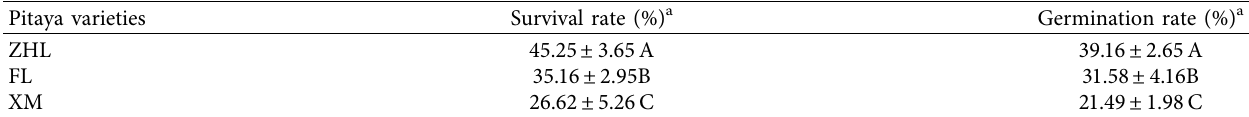
Table 2: The survival rate and germination rate of the annual branches of the three varieties of pitaya.